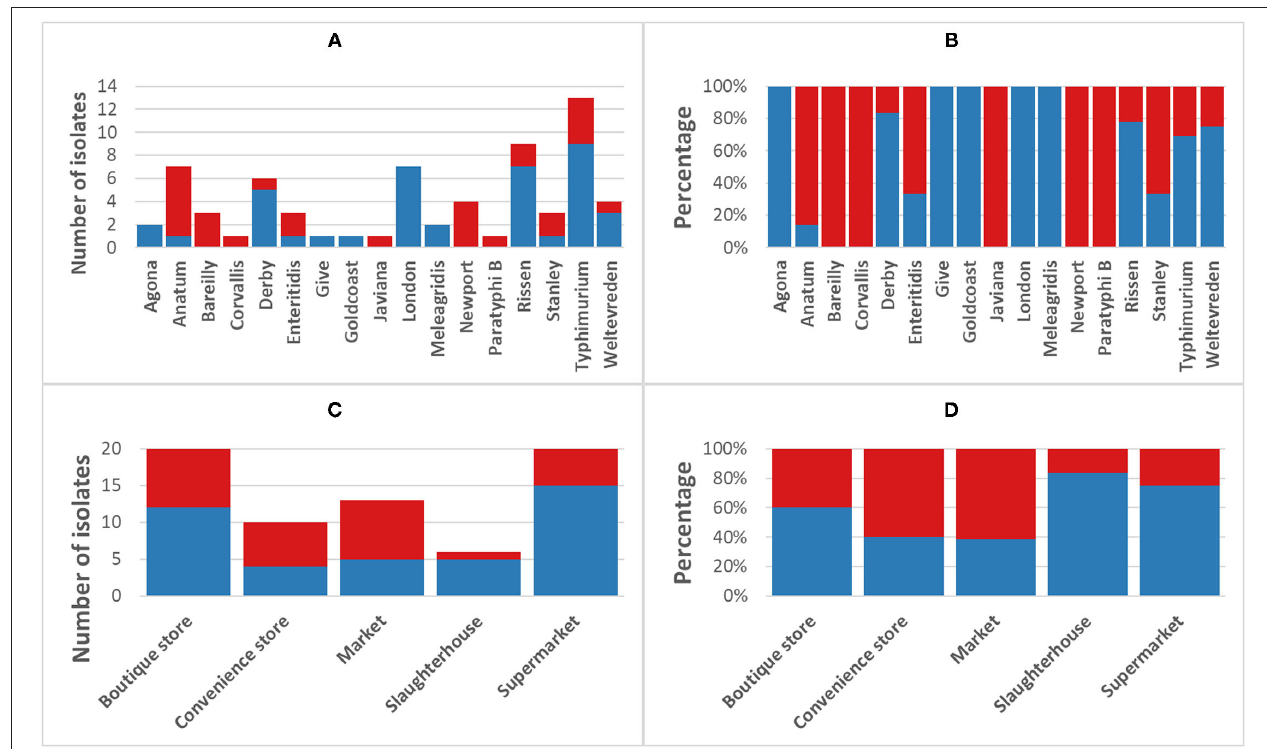
FIGURE 4 | Incidence of multi-drug resistant non-typhoidal salmonella (NTS). Blue, NTS isolates classified as multi-drug resistant [MDR] (fully resistant to at least 1 antimicrobial from ≥ 3 different antimicrobial classes); Red, non-MDR isolates. (A) Breakdown of MDR/non-MDR isolates by serotype, (B) Breakdown of MDR/non-MDR isolates by serotype as a percentage, (C) Breakdown of MDR/non-MDR isolates source by isolation source, and (D) Breakdown of MDR/non-MDR isolates source by isolation source as a